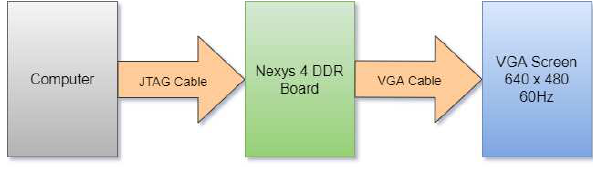
Figure 4. Block diagram of the work.